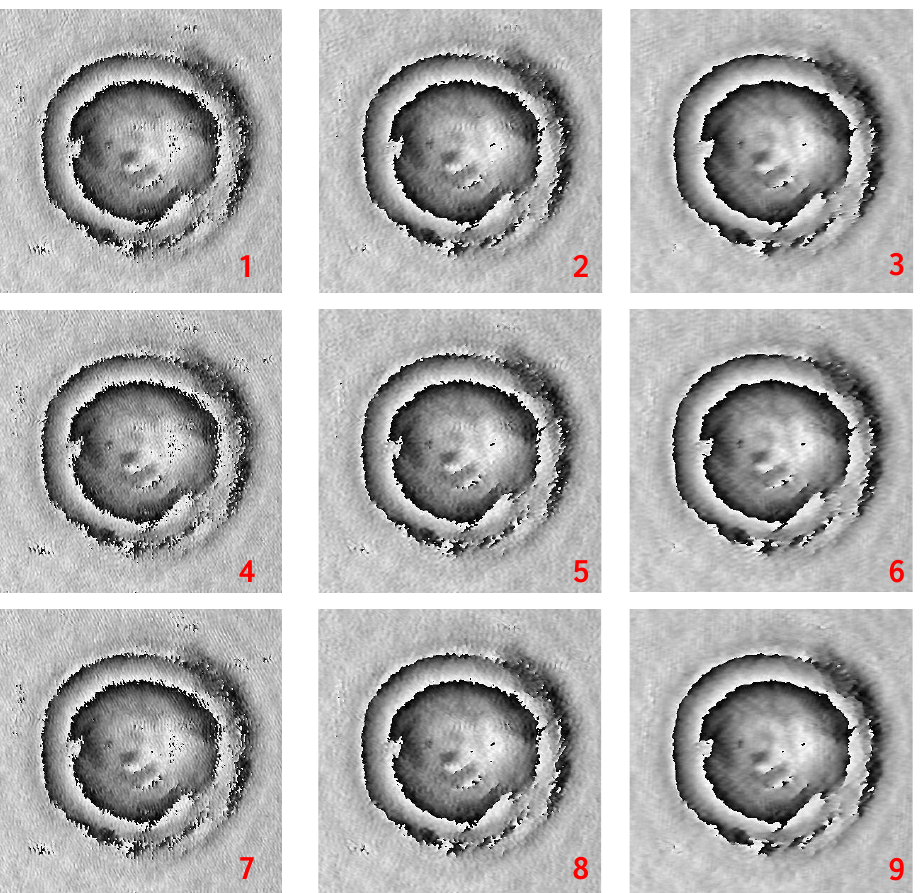
Figure 6. Phase difference of various windowed sidebands.